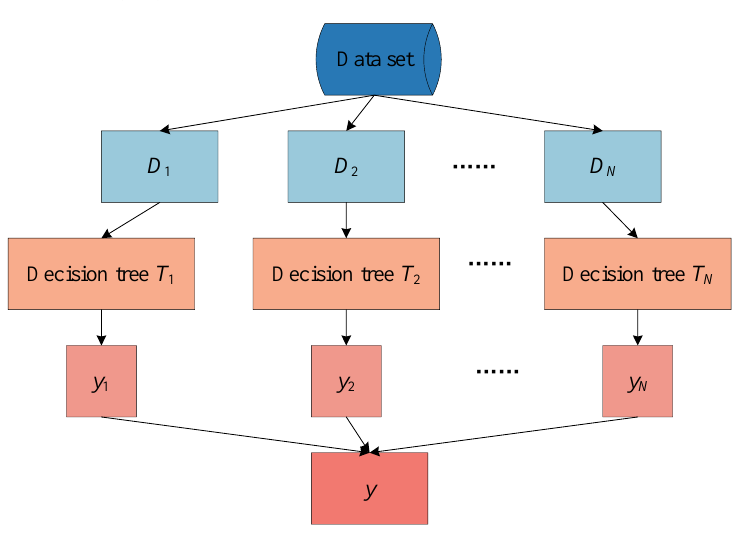
Figure 4. The flow chart of the RF.